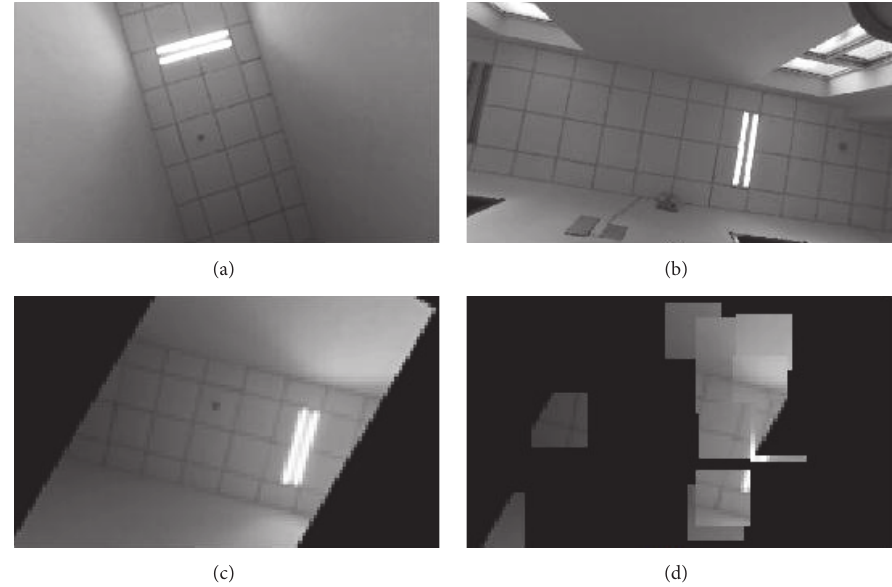
Figure 9: The rebuild overlap region by two dissimilar frames. (a) Frame 𝐴 , (b) frame 𝐵 , (c) the overlap region in frame 𝐴 , and (d) the rebuild overlap region in frame 𝐴